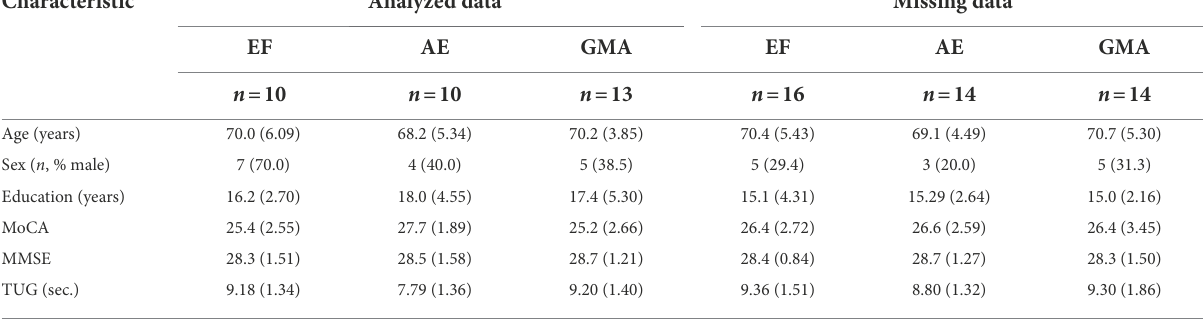
TABLE 2 Demographic information and baseline cognitive and physical capacity across training groups for participants included in the statistical analyses and participants who were not due to missing data.